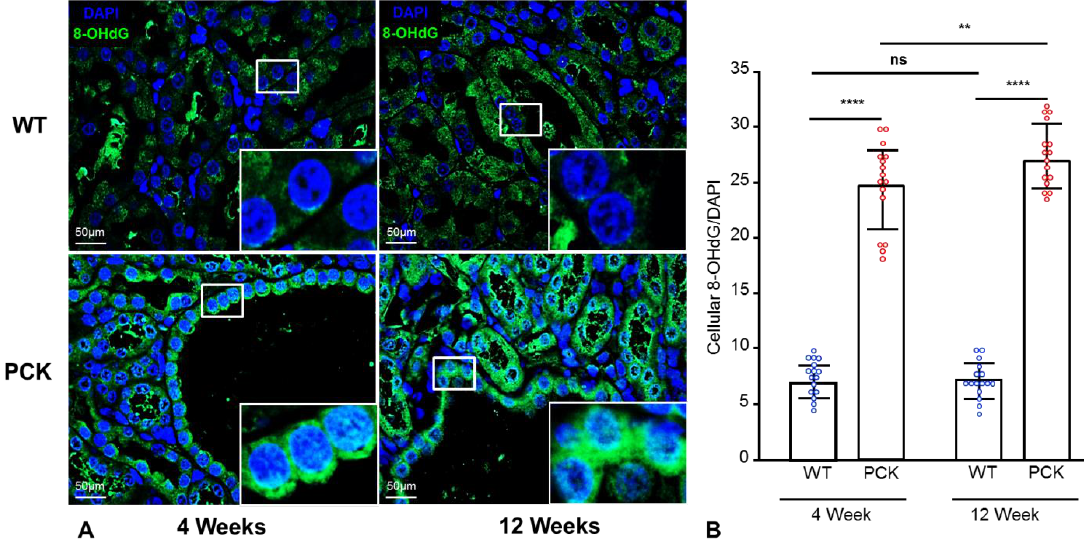
Figure 1. Renal oxidative stress worsens PKD progression. Representative immunofluorescence (IF) staining for 8-hydroxyguanosine (8-OHdG, green) in renal tissue sections of WT and PCK rats ( A ) and its quantification ( B ), showing increased 8-OHdG immunoreactivity in PCK vs. WT rats at 4 weeks, which further increased at 12 weeks; 8-OHdG was quantified as % stained area and adjusted to DAPI-stained % area. ** p < 0.01, **** p < 0.001. (n = 16 /